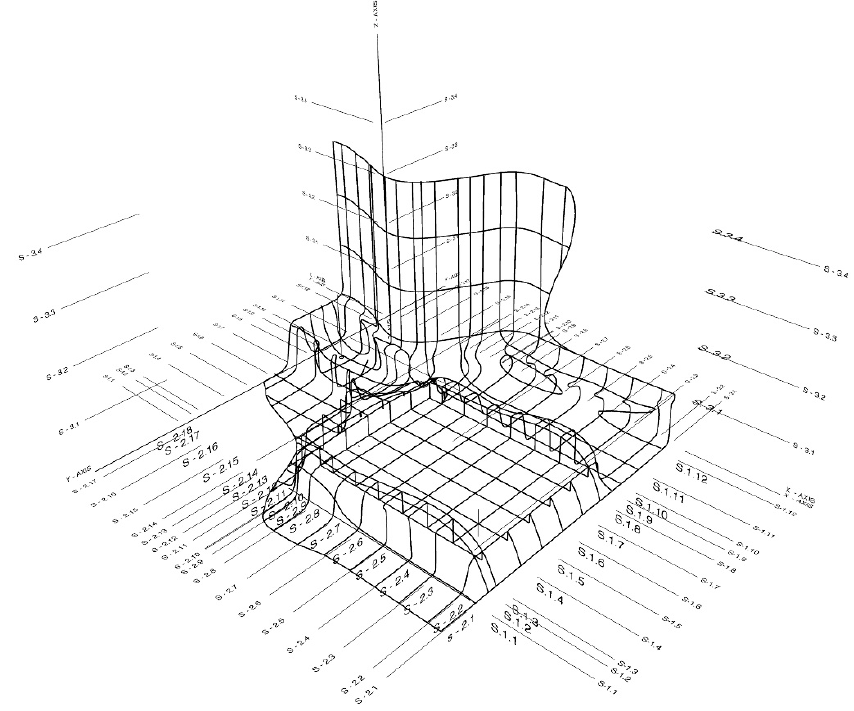
Figure 11. KOL/MAC, O-K apartment. Isometric view of combined fabrication templates for bath/bed element, 1996. Part of AP185.S2.020, last modified 21 October 1998. Gift of and © KOL/MAC.